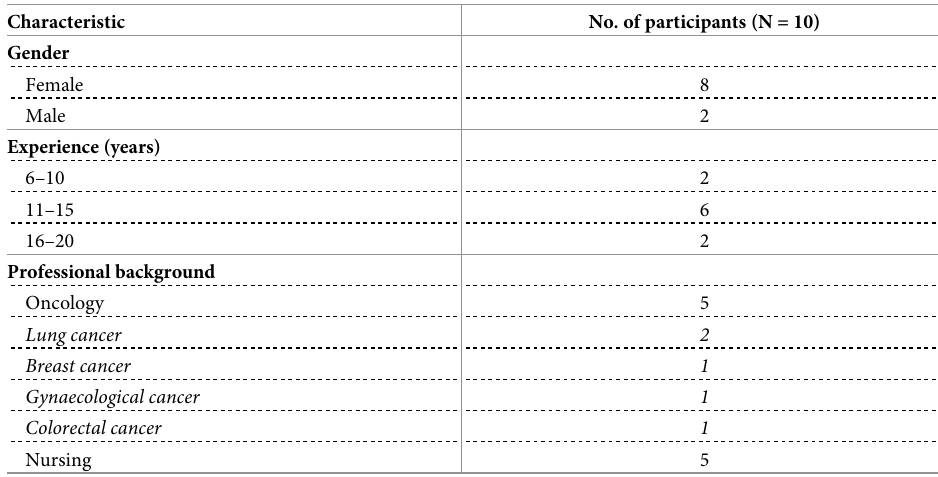
Table 1. Participant